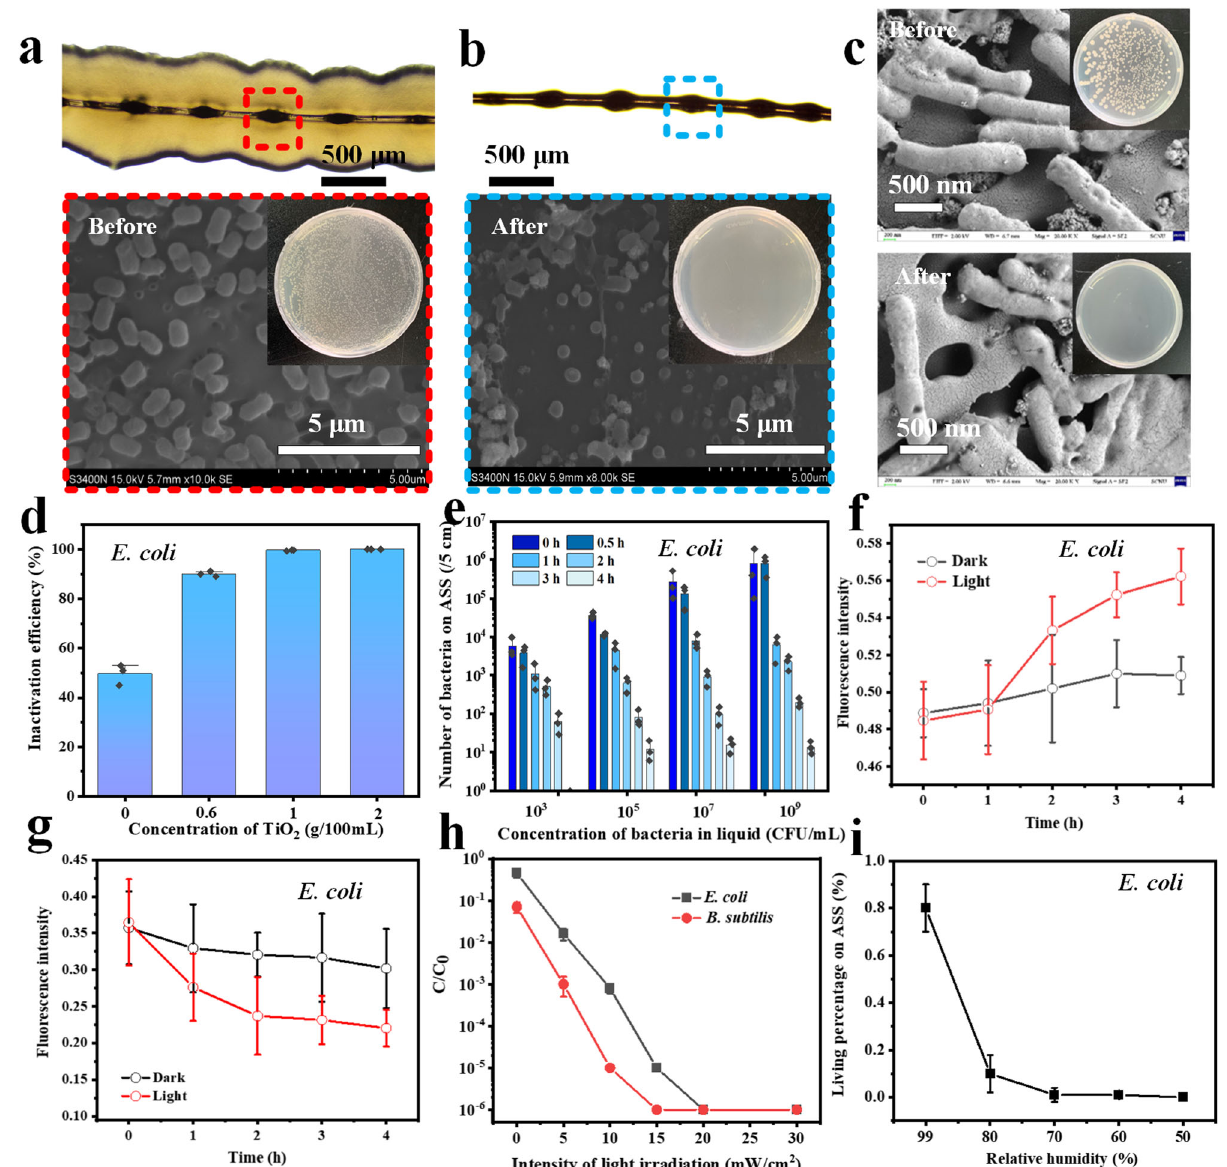
Fig. 4 | BioaerosolsinactivationperformanceoftheASSphotocatalyst. Optical andSEMimagesoftheASSphotocatalystafter E.coli bioaerosolscapturecultivated on nutrient medium a before and b after UV light irradiation (The independent experiment has been repeated for three times, and similar results were obtained). c SEM and optical images of B. subtilis captured by the ASS photocatalyst before and after irradiation (The independent experiment has been repeated for three times, and similar results were obtained). Inactivation ef fi ciency of the ASS pho- tocatalyst d with different TiO 2 loading and e at different irradiation time and concentration of bacteria (The error bars are calculated via repeating the